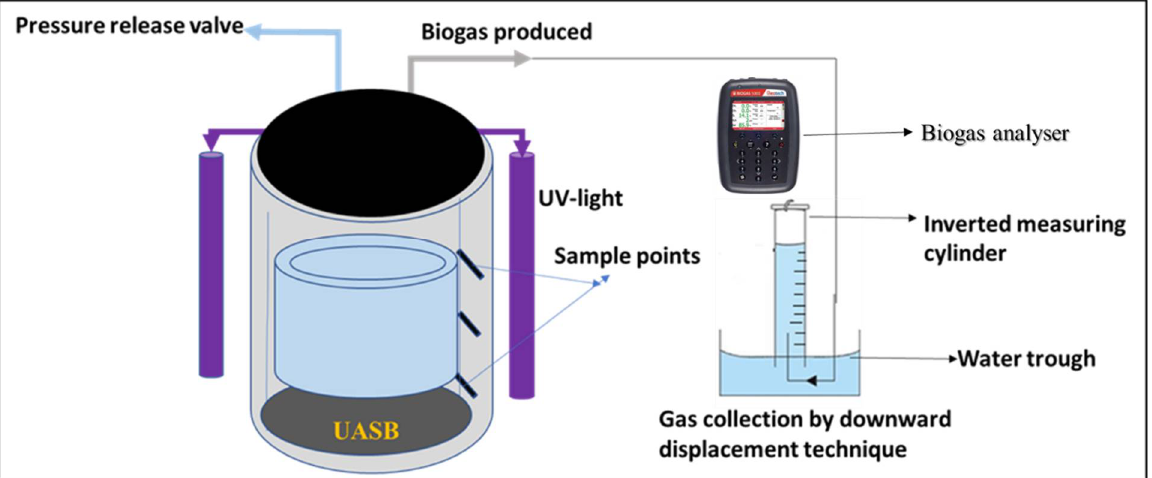
Figure 8. A schematic representation of the biophotocatalytic (BP) system consisting of the upflow anaerobic sludge blanket (UASB) reactor coupled with